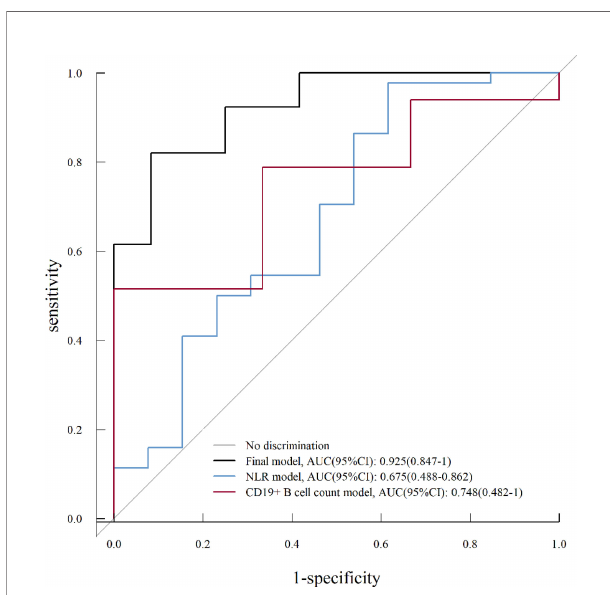
FIGURE 5 | Receiver operating characteristic (ROC) curve analysis for a univariate analysis (NLR model, CD19 + B-cell count model) and multivariate analysis ( fi nal model) on good prognosis (mRS score, ≤ 2) of severe AE. NLR, neutrophil-to-lymphocyte ratio; AUC, area under the curve; CI, con fi dence